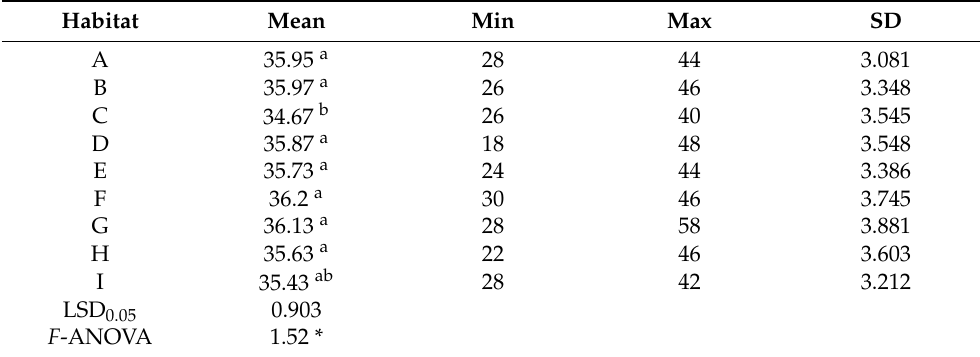
Table 3. Mean values, minimal, maximal and standard deviations (SD) as well as homogenous groups for length of the longest polar axis (LA), A–I abbreviated habitat names (see: Table 1).